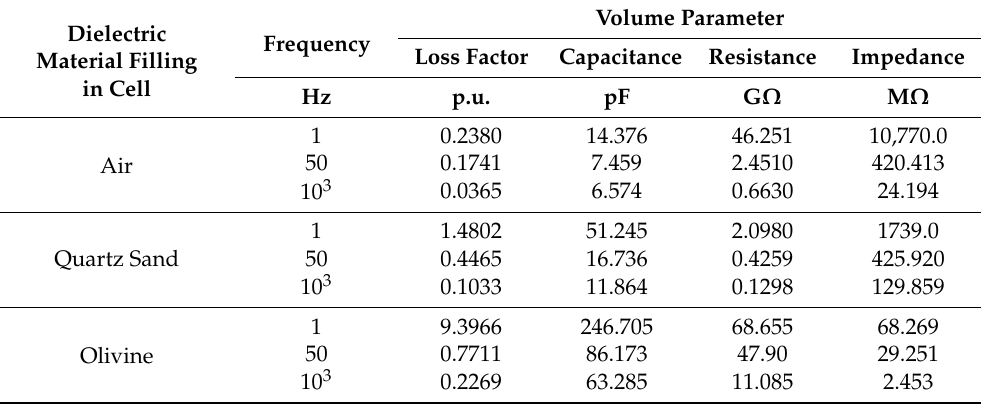
Table 2. Volume electrical properties of the DBD bed materials measured at frequencies from 1 Hz to 10 3